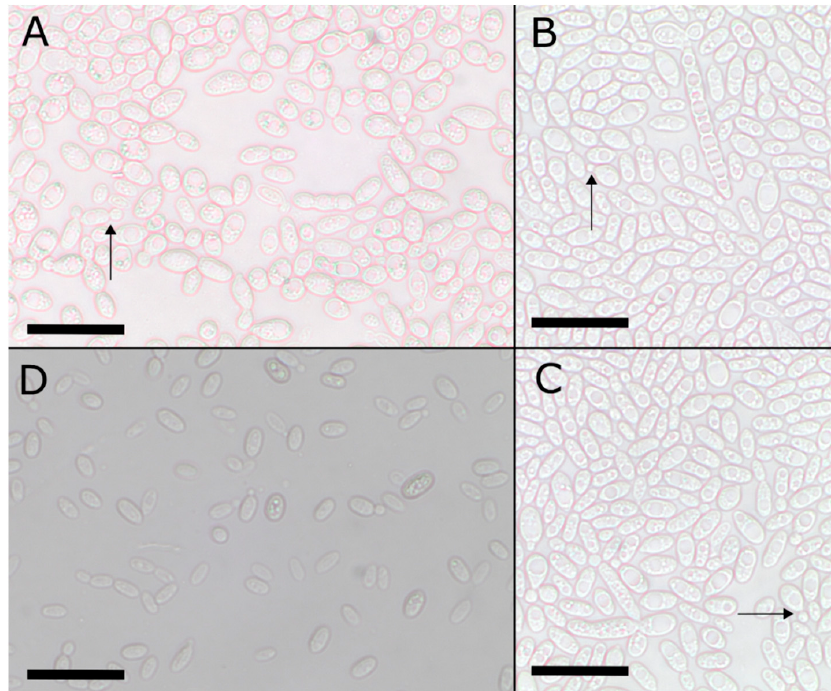
Figure 3. Sporobolomyces lactucae . ( A ). Morphology of S. lactucae after 7-day incubation at ambient conditions on PDA, photographed against a white background. ( B ). The same plate photographed against a black background.